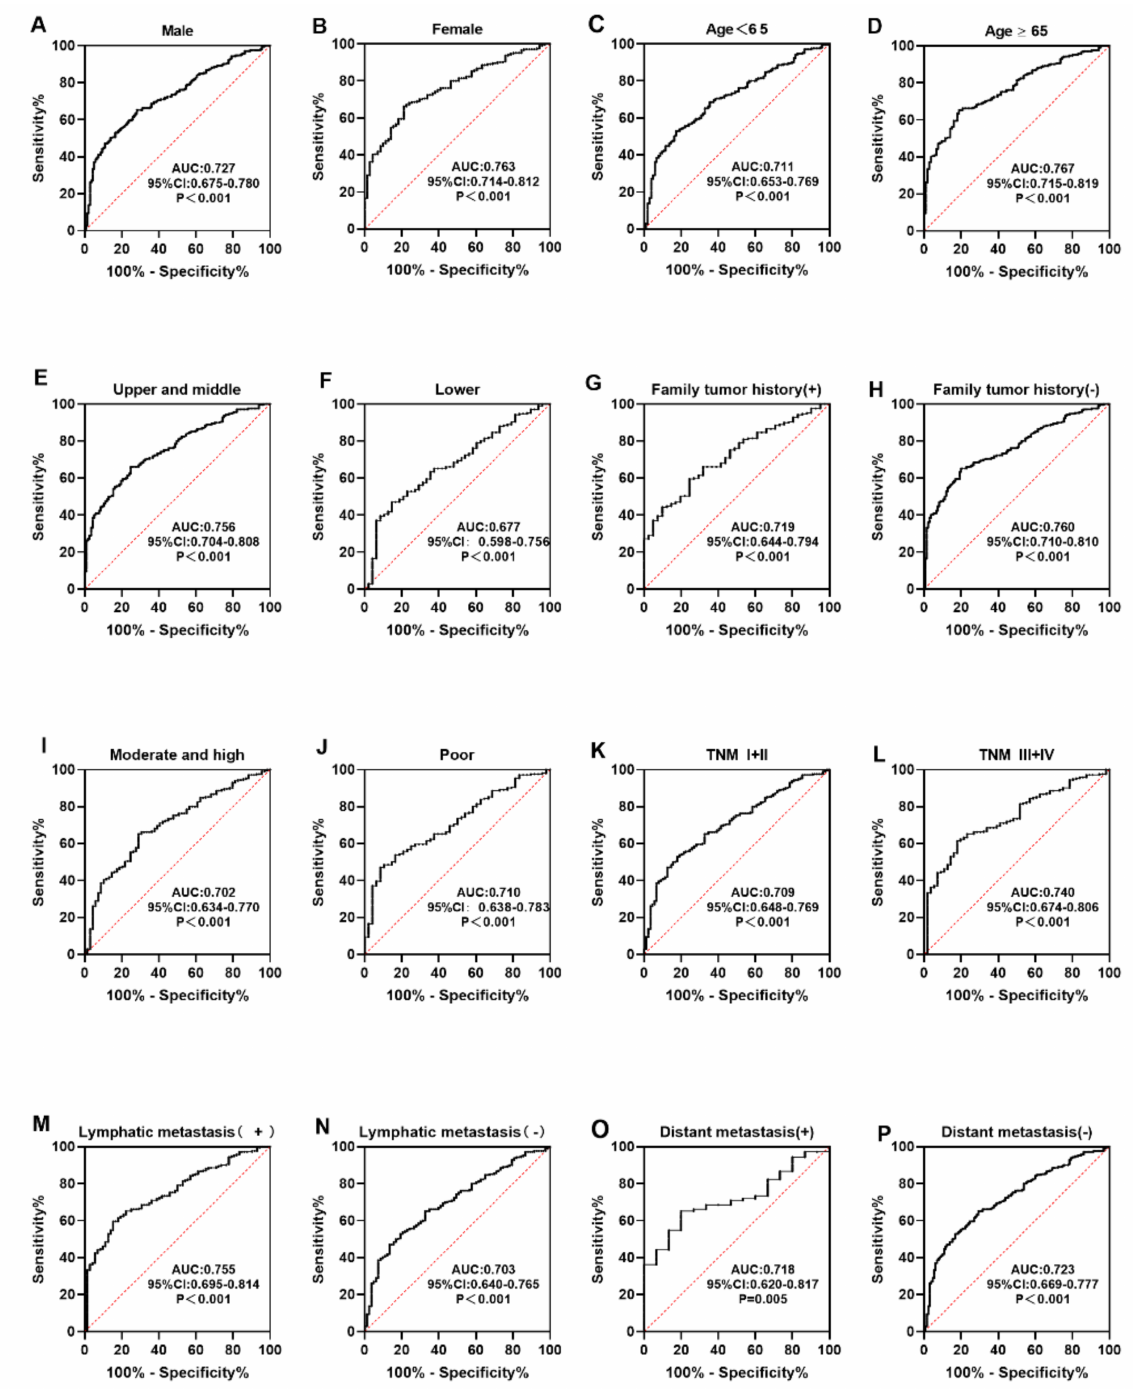
Figure 5. The expression of anti-CXCL8 autoantibody among subgroups of ESCC patients based on gender ( A , B ), age ( C , D ), tumor site ( E , F ), family tumor history ( G , H ), differentiation ( I , J ), TNM stage ( K , L ), lymph node metastasis ( M , N ), and distant metastasis ( O , P